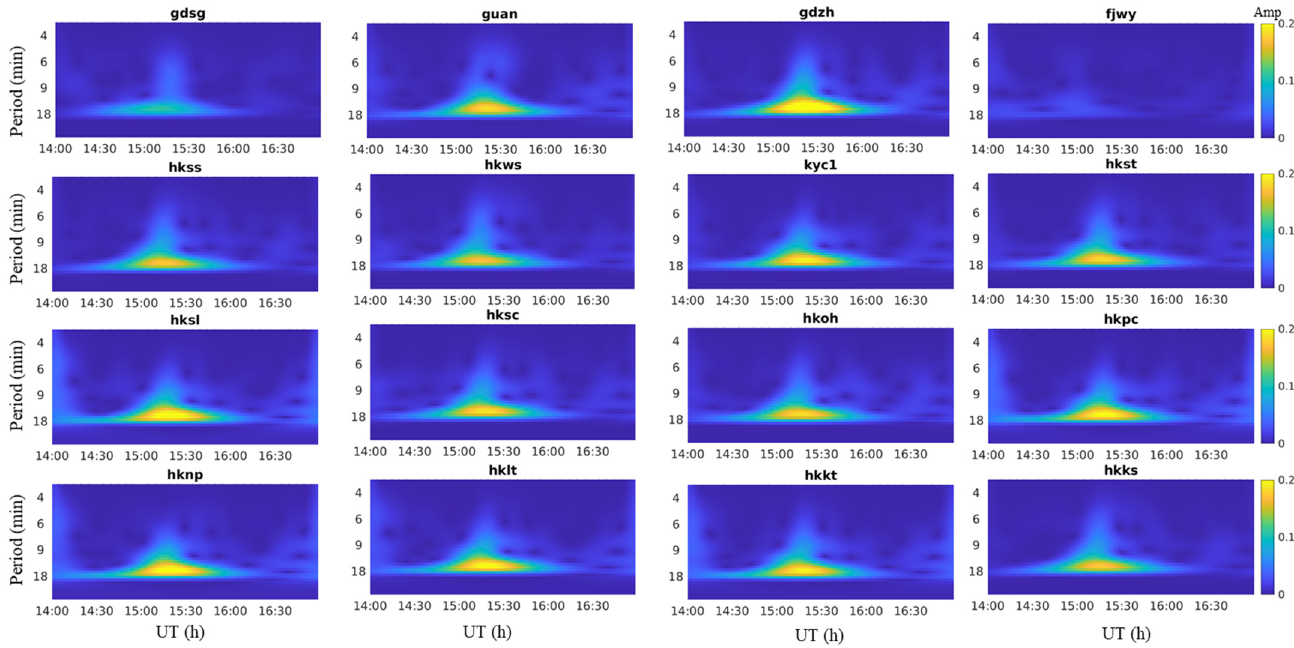
Figure 6. Wavelet analysis of PRN 2 from multiple station observations on 3 April 2019 to explore GW perturbation periodicities. The horizontal coordinate is universal time; the vertical coordinate is period; and the color axis is the perturbation magnitude. The characteristics of the period of PRN 6 are similar to PRN 2.